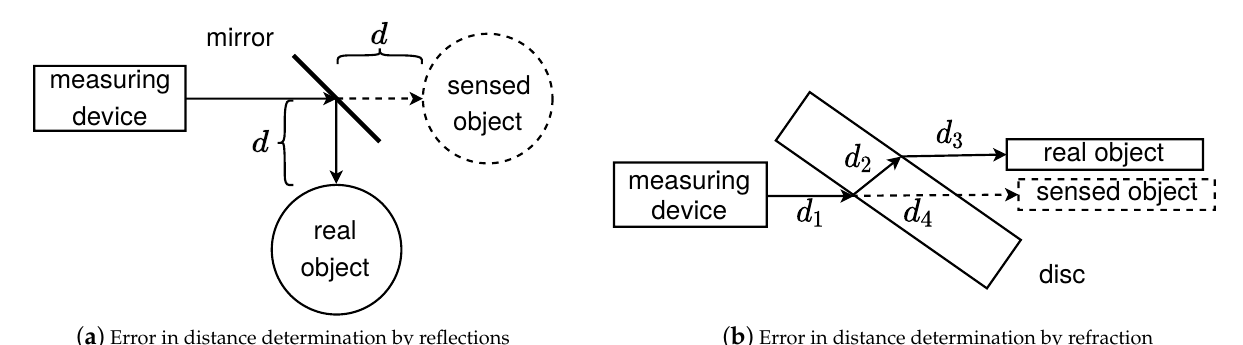
( b ) Error in distance determination by refraction Figure 2. ( a ) The sketch shows a measuring device, a mirror, and a target object. A beam is emitted from the measuring device in the direction of the mirror. There it is deflected by 90° and hits an object. At this object the beam is reflected and returns on the same path. ( b ) The drawing depicts a measuring device, a glass plane and a target object. The beam hits the glass pane, is refracted at the air-glass and glass-air boundaries and then runs parallel to the original